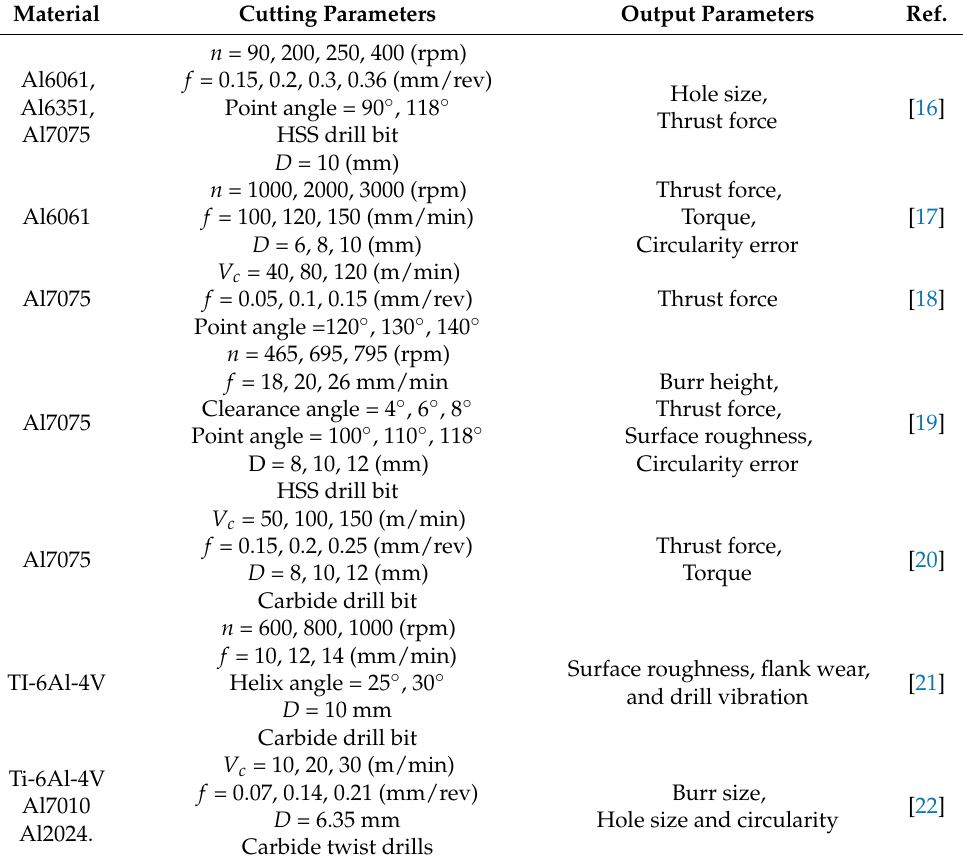
Table 1. Previous work on the effect of drilling parameters: Aluminium/other metals. Material Cutting Parameters Output